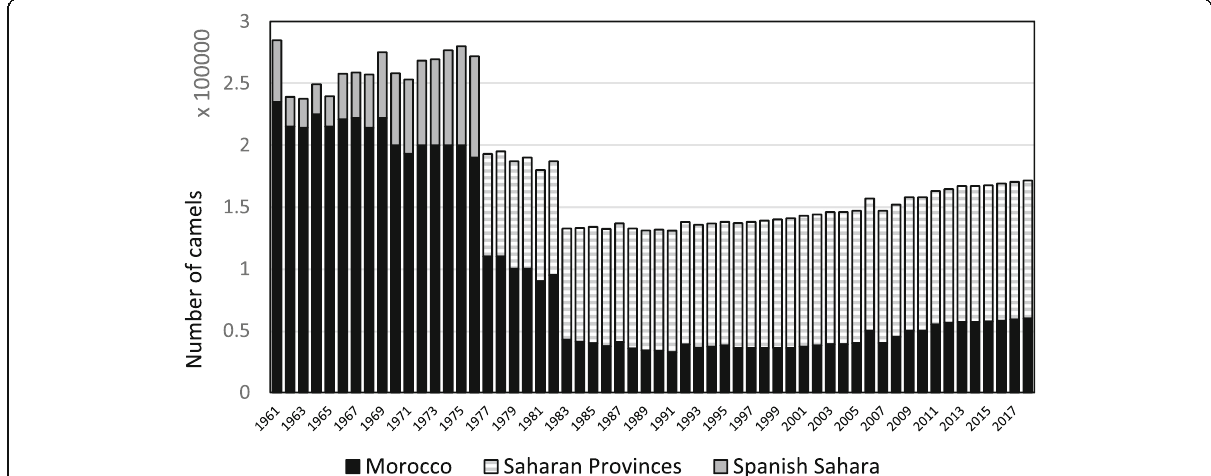
Fig. 17 Changes in camel stock in Morocco (1961 – 2018) and in Sahara during Spanish colonization (1961 – 1976) and after inclusion in